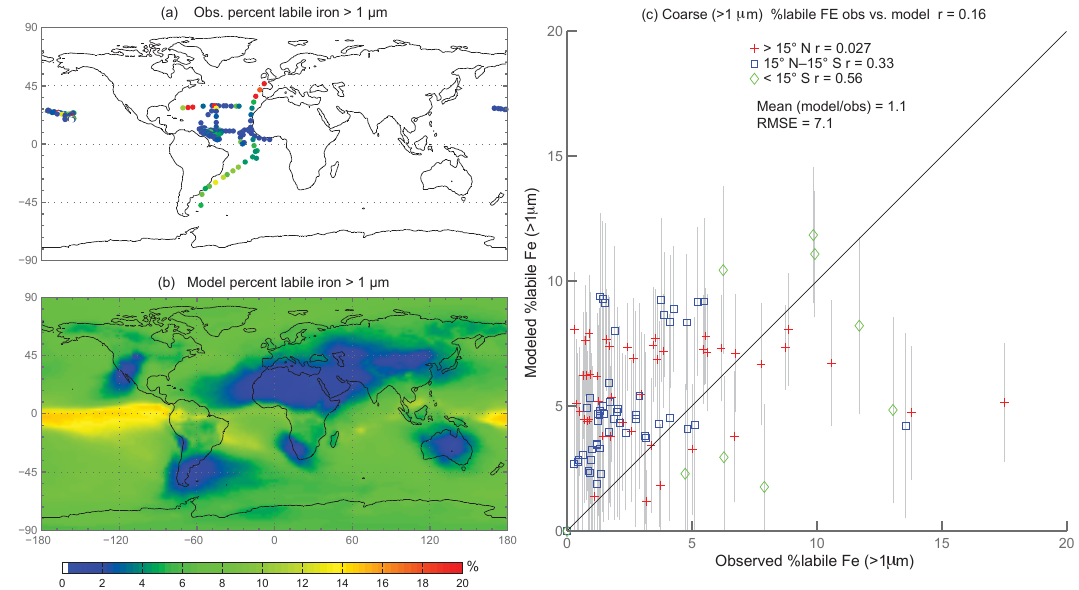
Figure 4. Observations (a) and modeled surface concentrations (b) of percent labile iron for particle diameter > 1µm. Scatterplot of observed coarse-mode percent labile Fe versus modeled coarse-mode percent labile Fe (c) . Red crosses indicate observations about 15 ◦ N, blue boxes indicate observations between 15 ◦ S and 15 ◦ N, and green diamonds indicate observations below 15 ◦ S. Grey vertical lines correspond to 1 standard deviation of model daily averaged concentrations between 2007 and 2011.